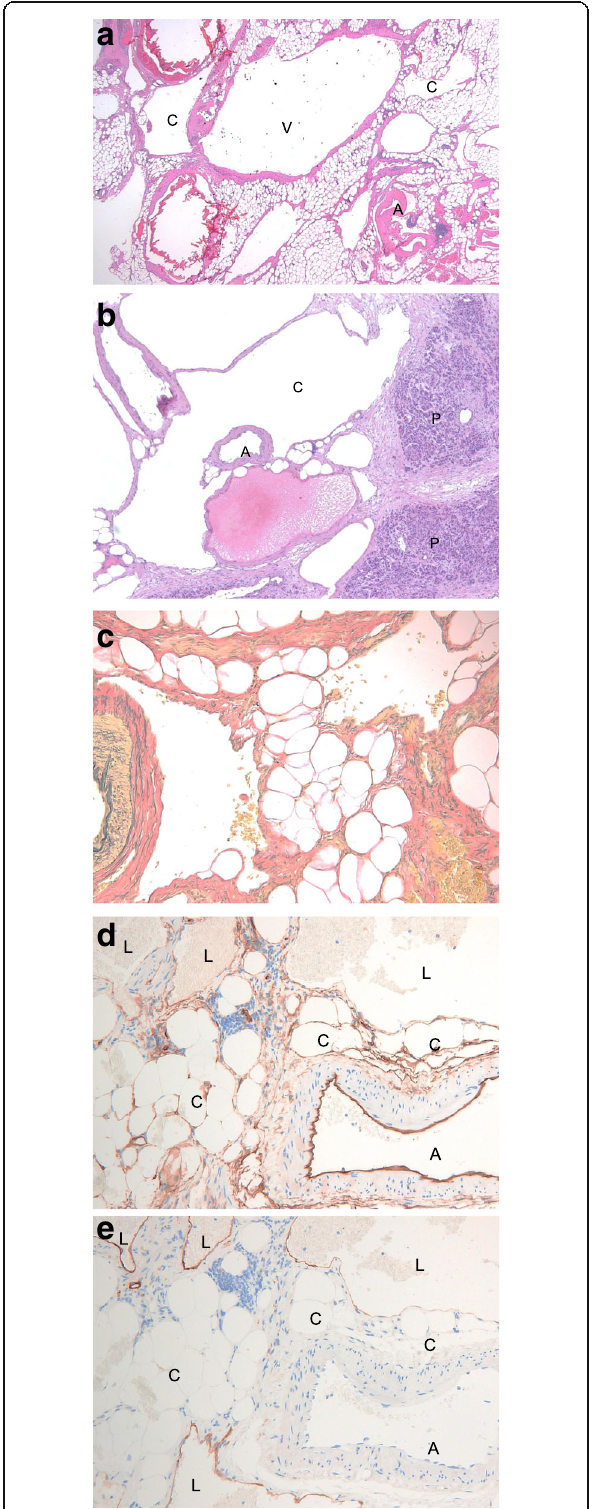
Fig. 5 The histopathological findings showed complex multiple small vessels ( a ) (A, artery; V, vein; C, capillary). The pancreatic tissue was recognized within the tumor ( b ) (A, artery; C, capillary; P pancreas). Elastica van Gieson staining was negative for most small vessels ( c ). CD34 was positive for capillaries including a small artery ( d ) (A, artery; C, capillary L; lymphatic duct). D2-40 staining was positive for only the lymphatic ducts ( e ) (A, artery; C, capillary; L, lymphatic